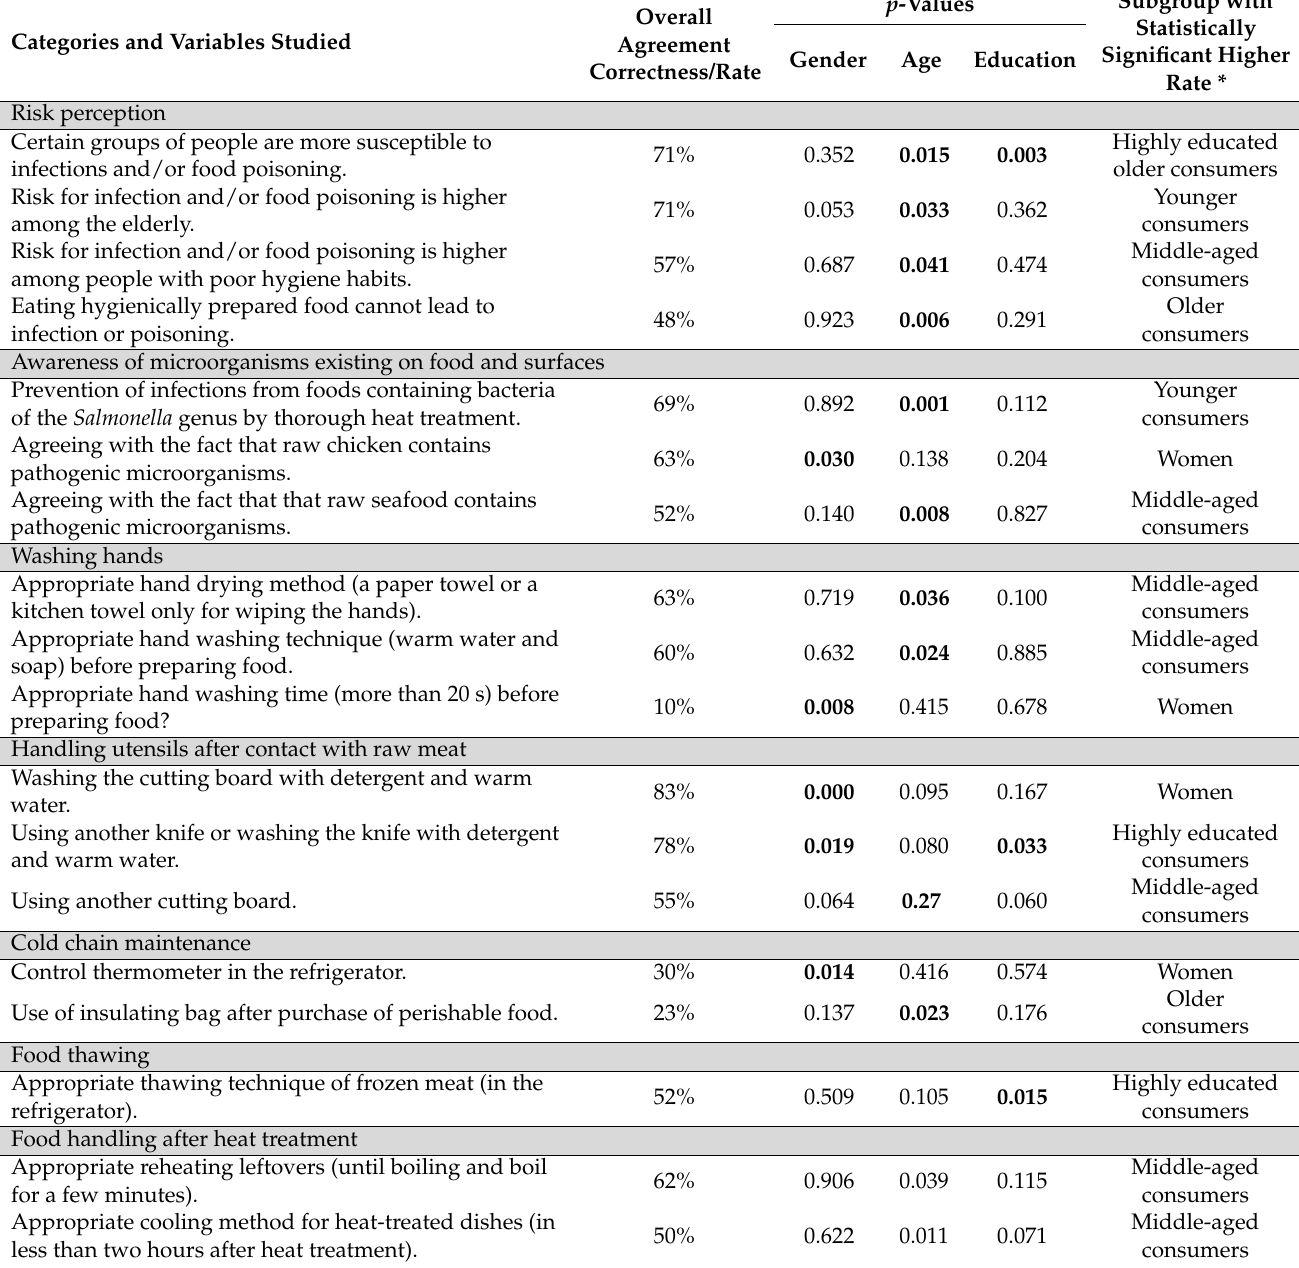
Table 3. Overall results of the questionnaire analysis and statistical significance ( p < 0.05) by